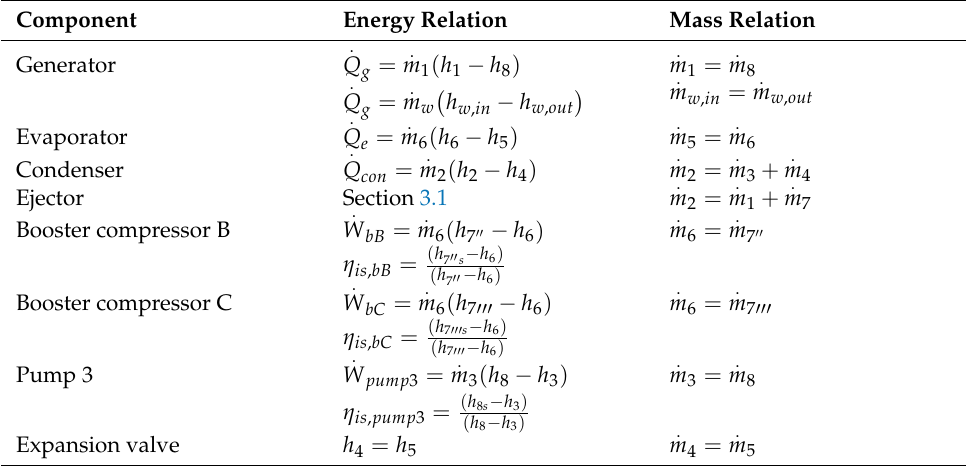
Table 3. Mass and energy relations for the refrigeration sub-system components